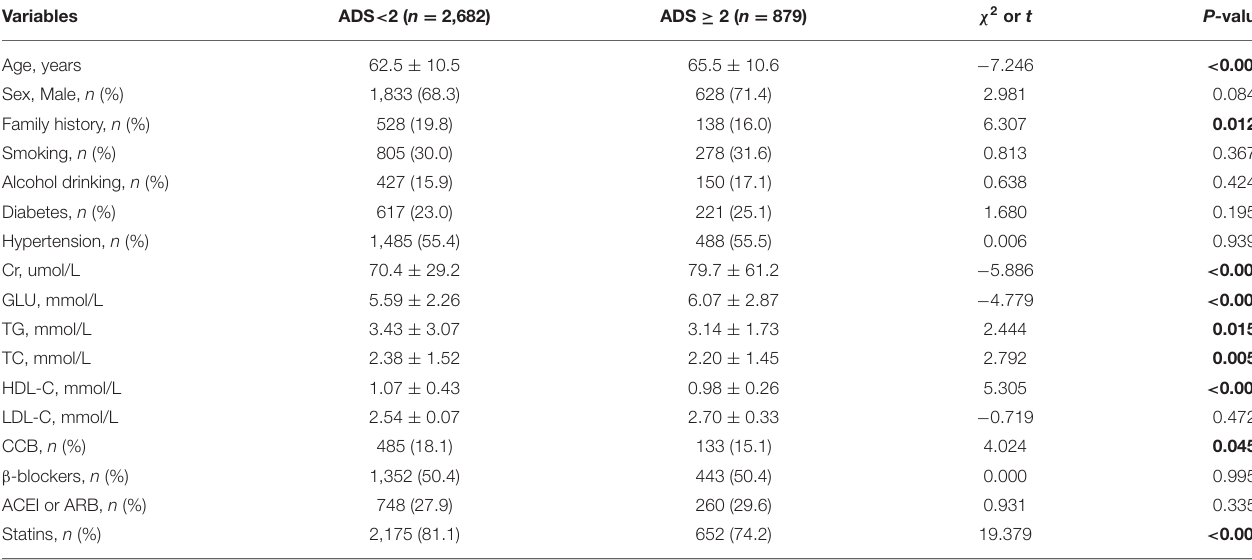
TABLE 1 | Characteristics of participants of the two